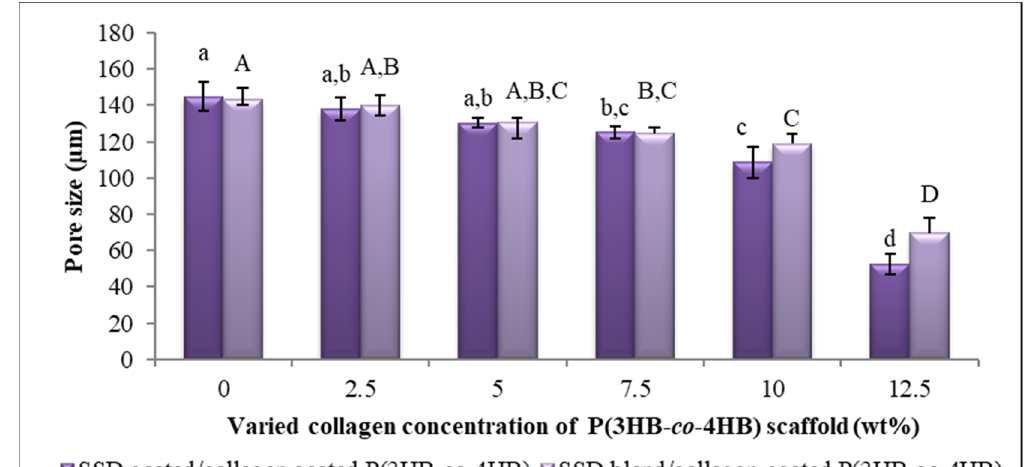
Figure 5. Porosity analysis of SSD coated/collagen coated P(3HB- co -4HB); SCCC and SSD blend/collagen coated P(3HB- co -4HB); SBCC scaffolds. Data represent means ± SD ( n = 3). Mean data accompanied by different alphabets as of SCCC scaffolds (a–d) and SBCC scaffolds (A–D) indicates significant difference within each respective group (Tukey’s HSD test, p < 0.05).